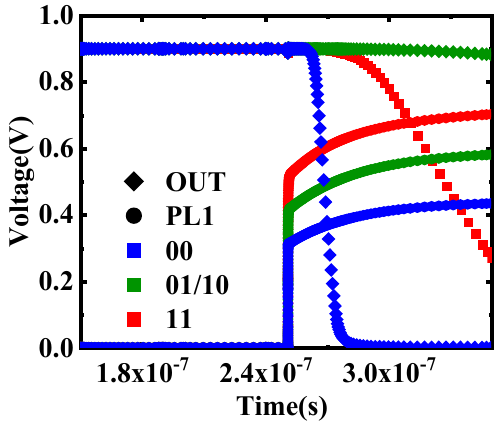
Figure 17. The simulation results of X(N)OR.